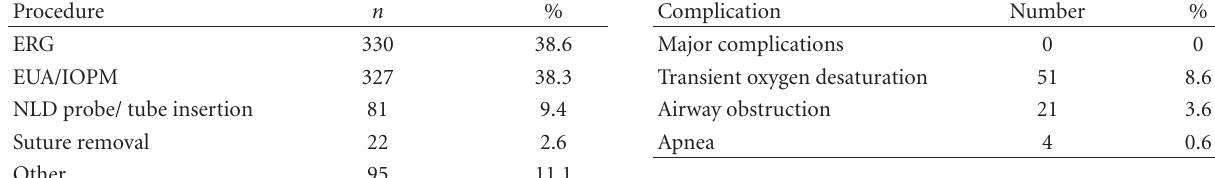
Table 4: Most common procedures performed.